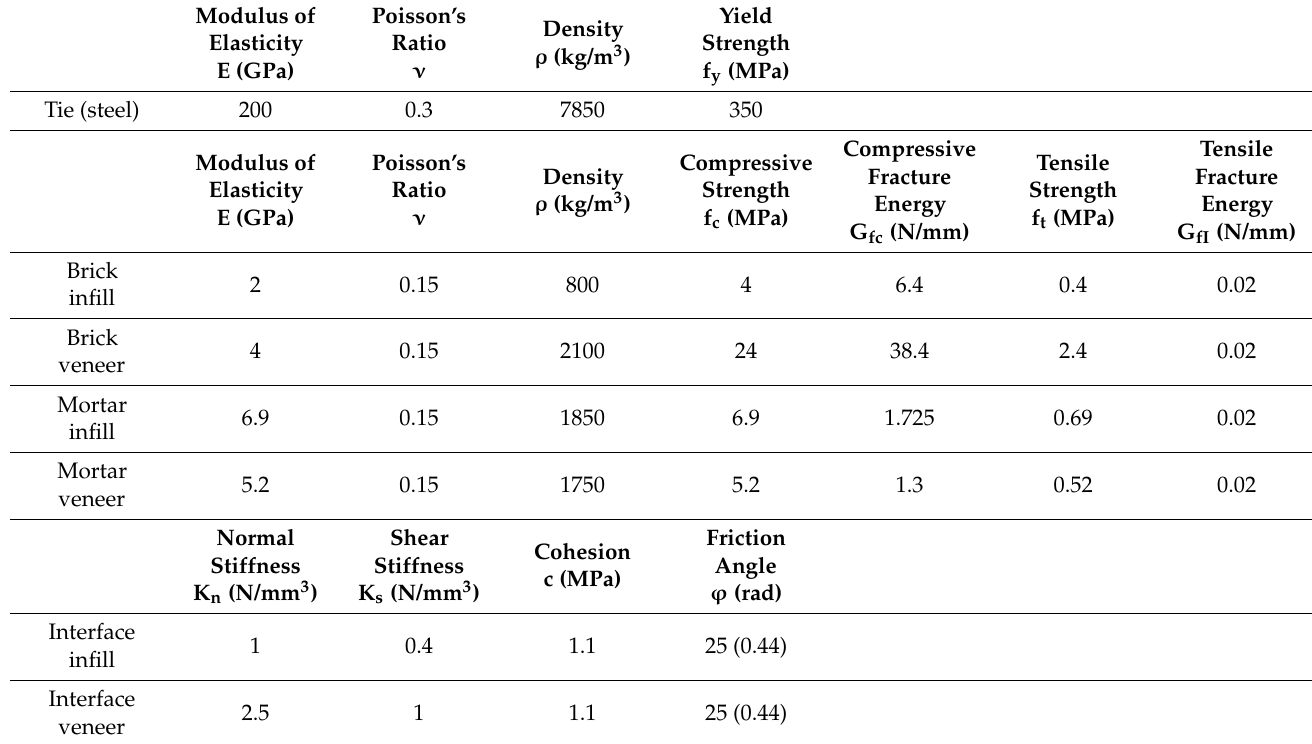
Table 1. Material properties adopted for the numerical